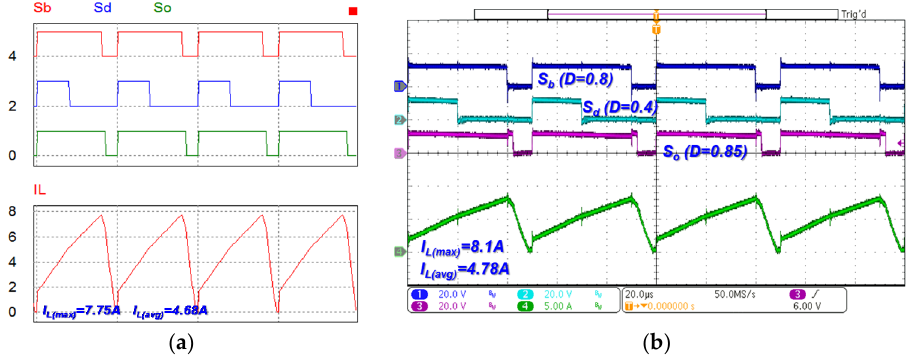
Figure 6. Gate driving signal and inductor current waveforms in the battery discharging mode: ( a ) by simulation; and ( b ) by measurement.